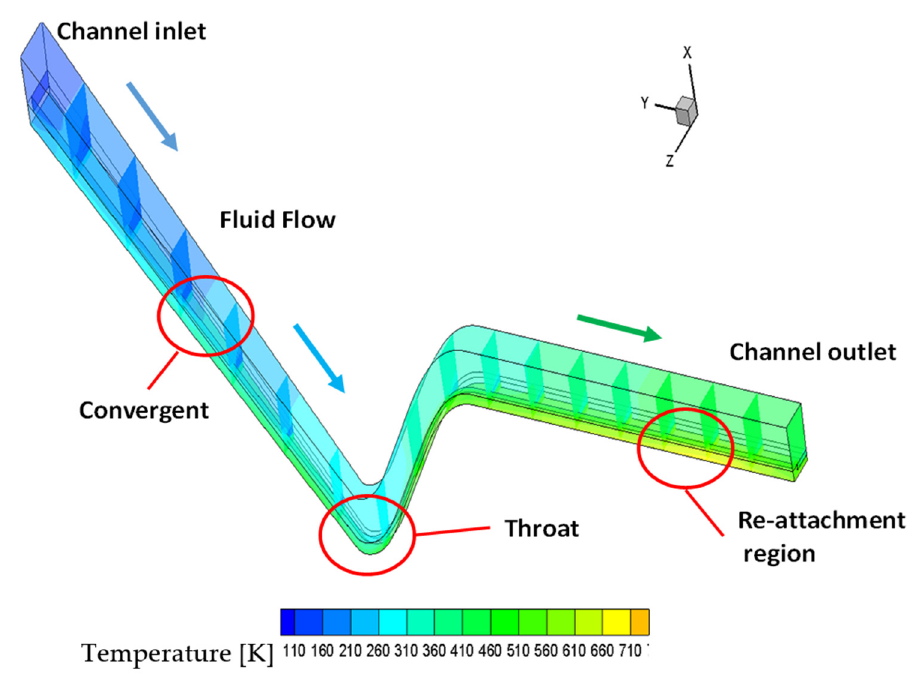
Figure 16. DEMO-0A: Temperature field of channel walls, including some slices—methane-cooled mode.